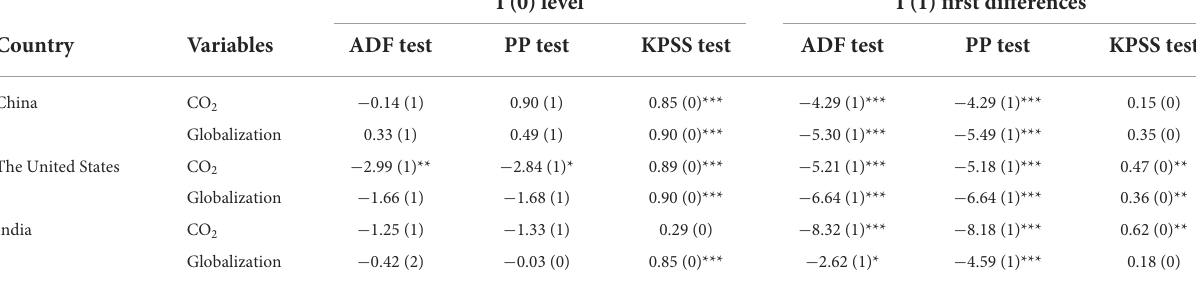
TABLE 2 Results of the unit root test.